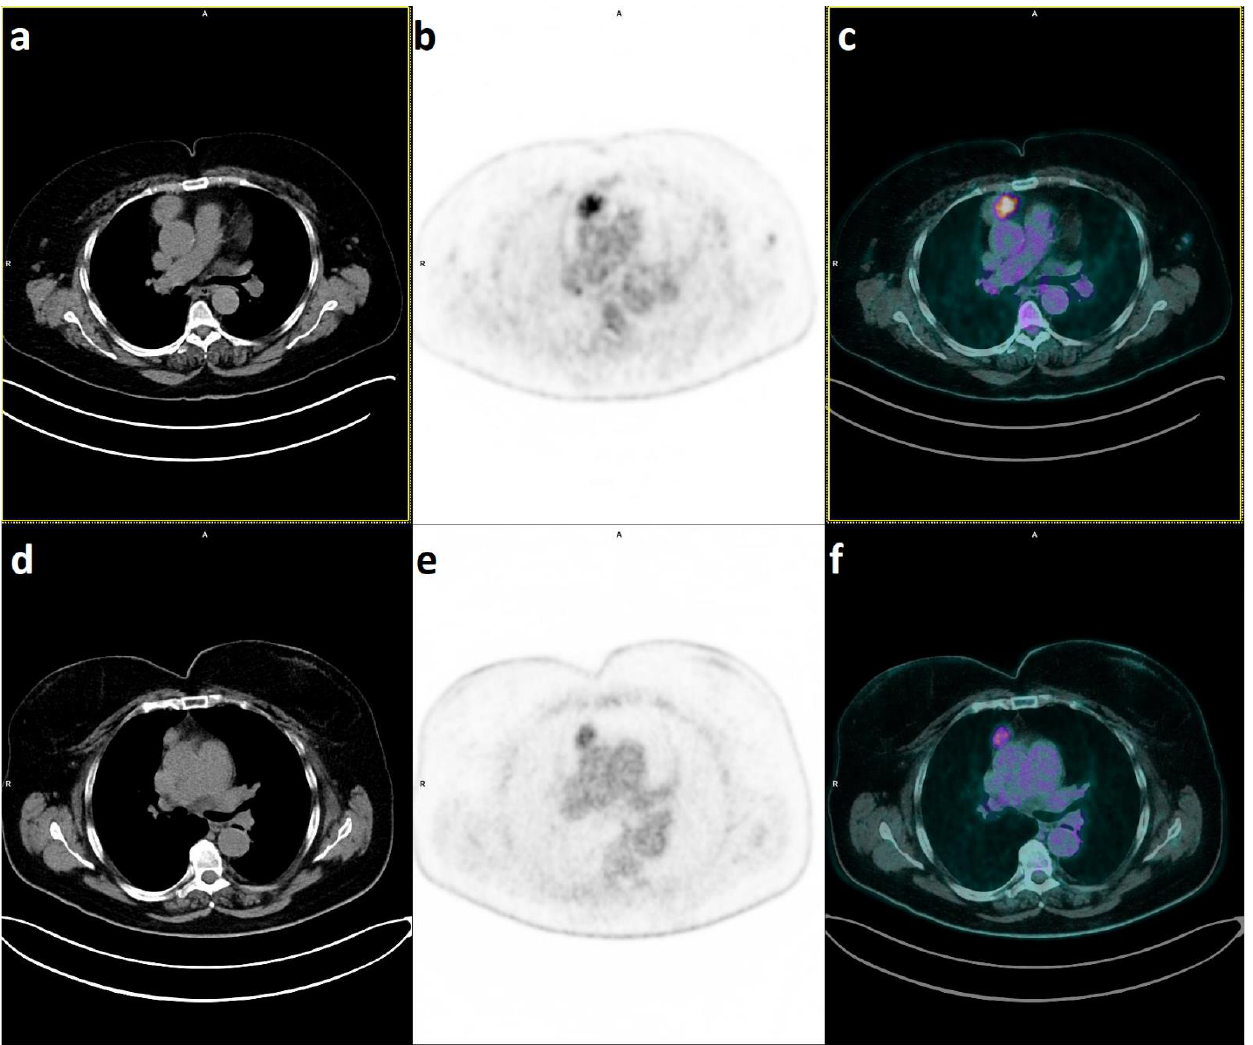
Figure 2. PET CT scan showing the absence of mild uptake in a case of Type AB-Thymoma (Figure 2 ( a – c )) [18] compared with intense uptake in a Type B3-Thymoma (Figure 2 ( d – f ))